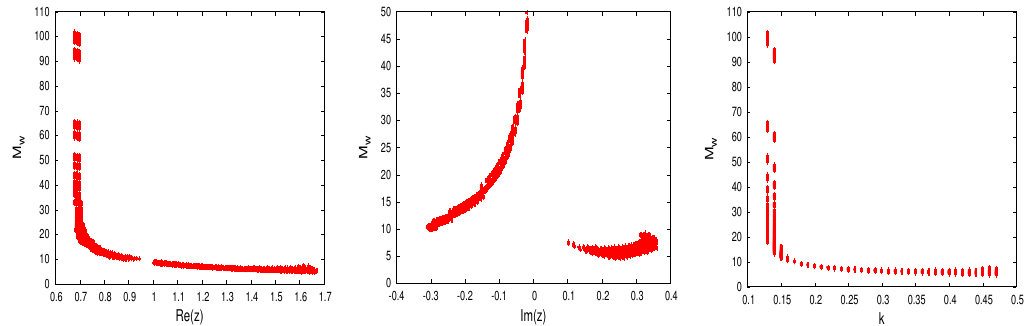
Figure 8 . Allowed M w constrained by the baryon asymmetry bound for the whole 3 (cid:27) parameter space of oscillation data. ( Y B has been calculated using (cid:20) f that of (cid:20) (cid:12)t